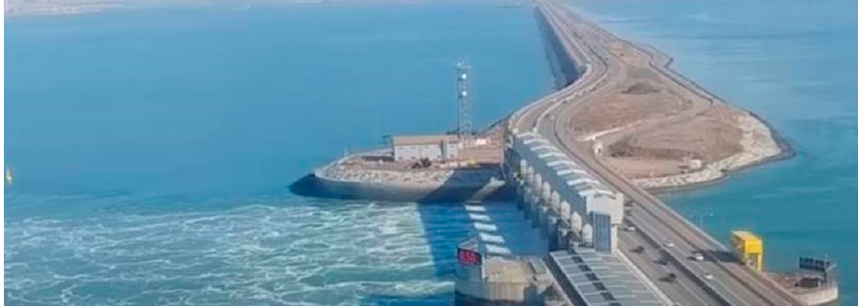
Figure 27. The Sihwa Lake tidal power station in South Korea [65].